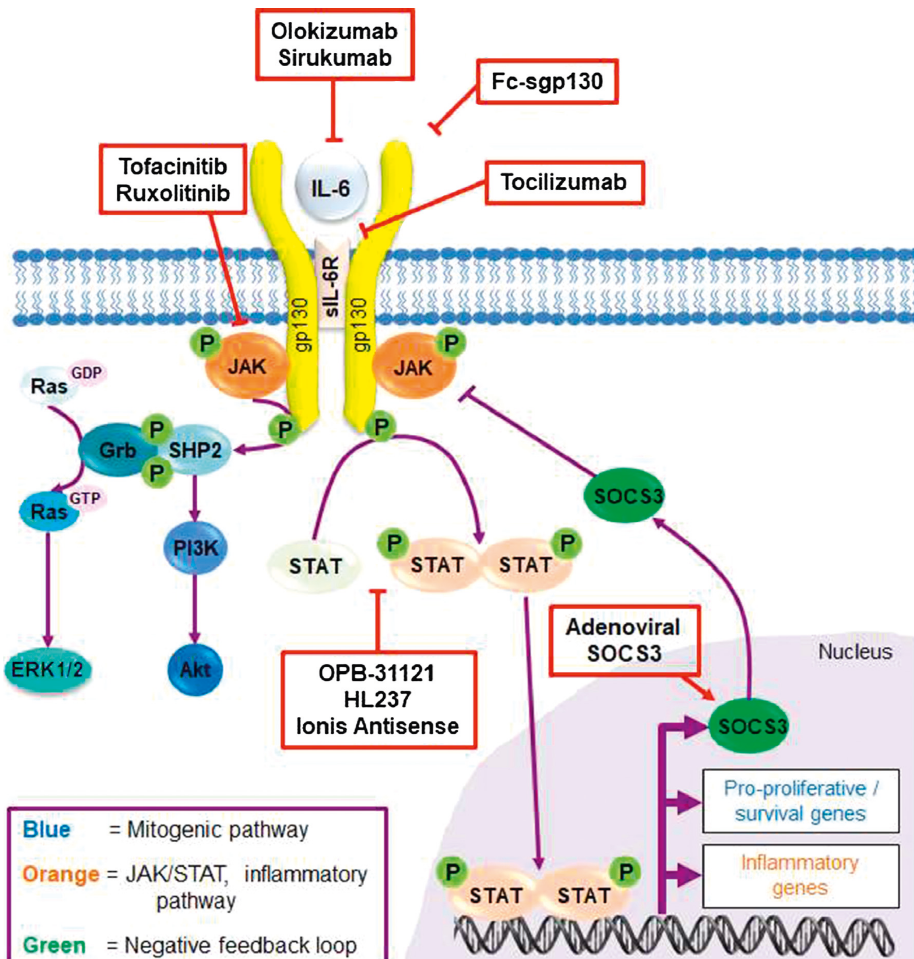
Figure 4: The IL-6–JAK/STAT–SOCS3 signalling pathway. The principal signalling pathway triggered by IL-6 is the JAK/STAT pathway (orange). JAK phosphorylates gp130 leading to phosphorylation and dimerisation of STAT, which translocates to the nucleus to induce expression of prosurvival and proinflammatory genes. It also induces expression of SOCS3 as a negative feedback loop to switch off the signalling pathway (green). SOCS3 forms part of the E3 ubiquitin ligase complex to ubiquitinate JAK, leading to proteasomal degradation and termination of the signalling cascade. JAK can also act independently of STAT to trigger additional mitogenic and growth-promoting effects via the PI3K/Akt and ERK1/2 pathways (blue). Sites of action of specific therapeutic inhibitors are indicated in red